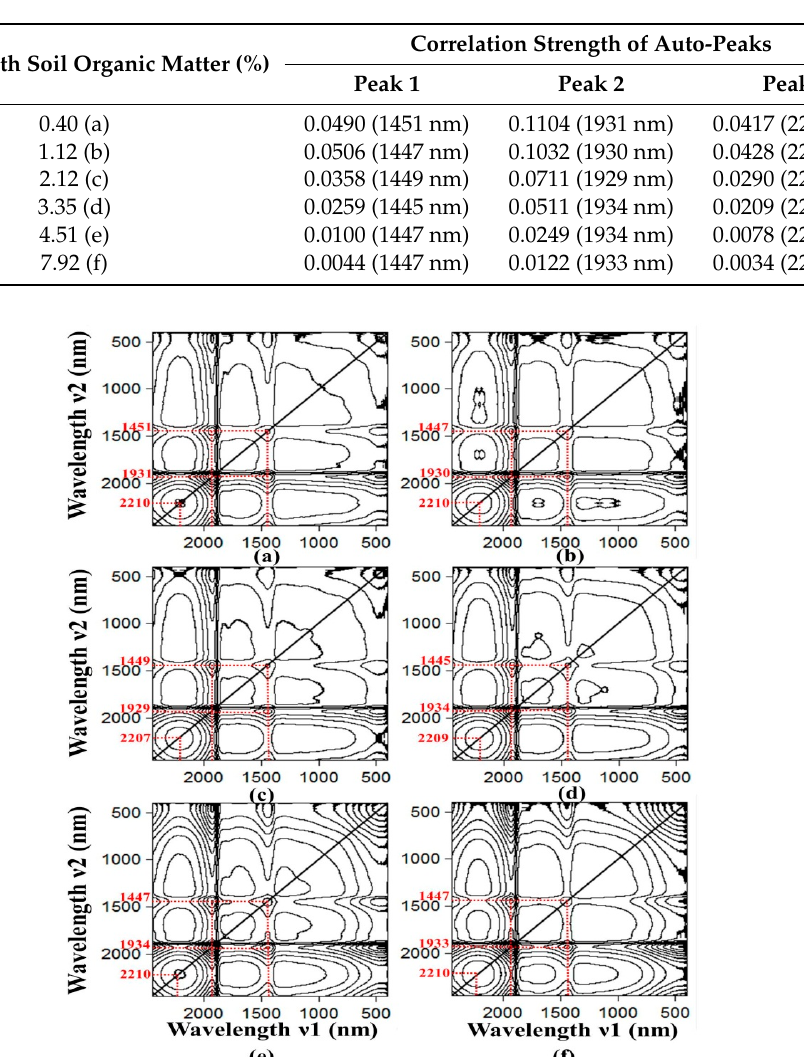
Figure 5. The contour plots of the synchronous two-dimensional correlation spectroscopy (2D-COS) of the soil samples that have SOM content of: ( a ) 0.40%, ( b ) 1.12%, ( c ) 2.12%, ( d ) 3.35%, ( e ) 4.51% and ( f ) 7.92%. Note that the 2D-COS is formed by using spectra of samples that have been dosed by various moisture contents in each category of SOM content.